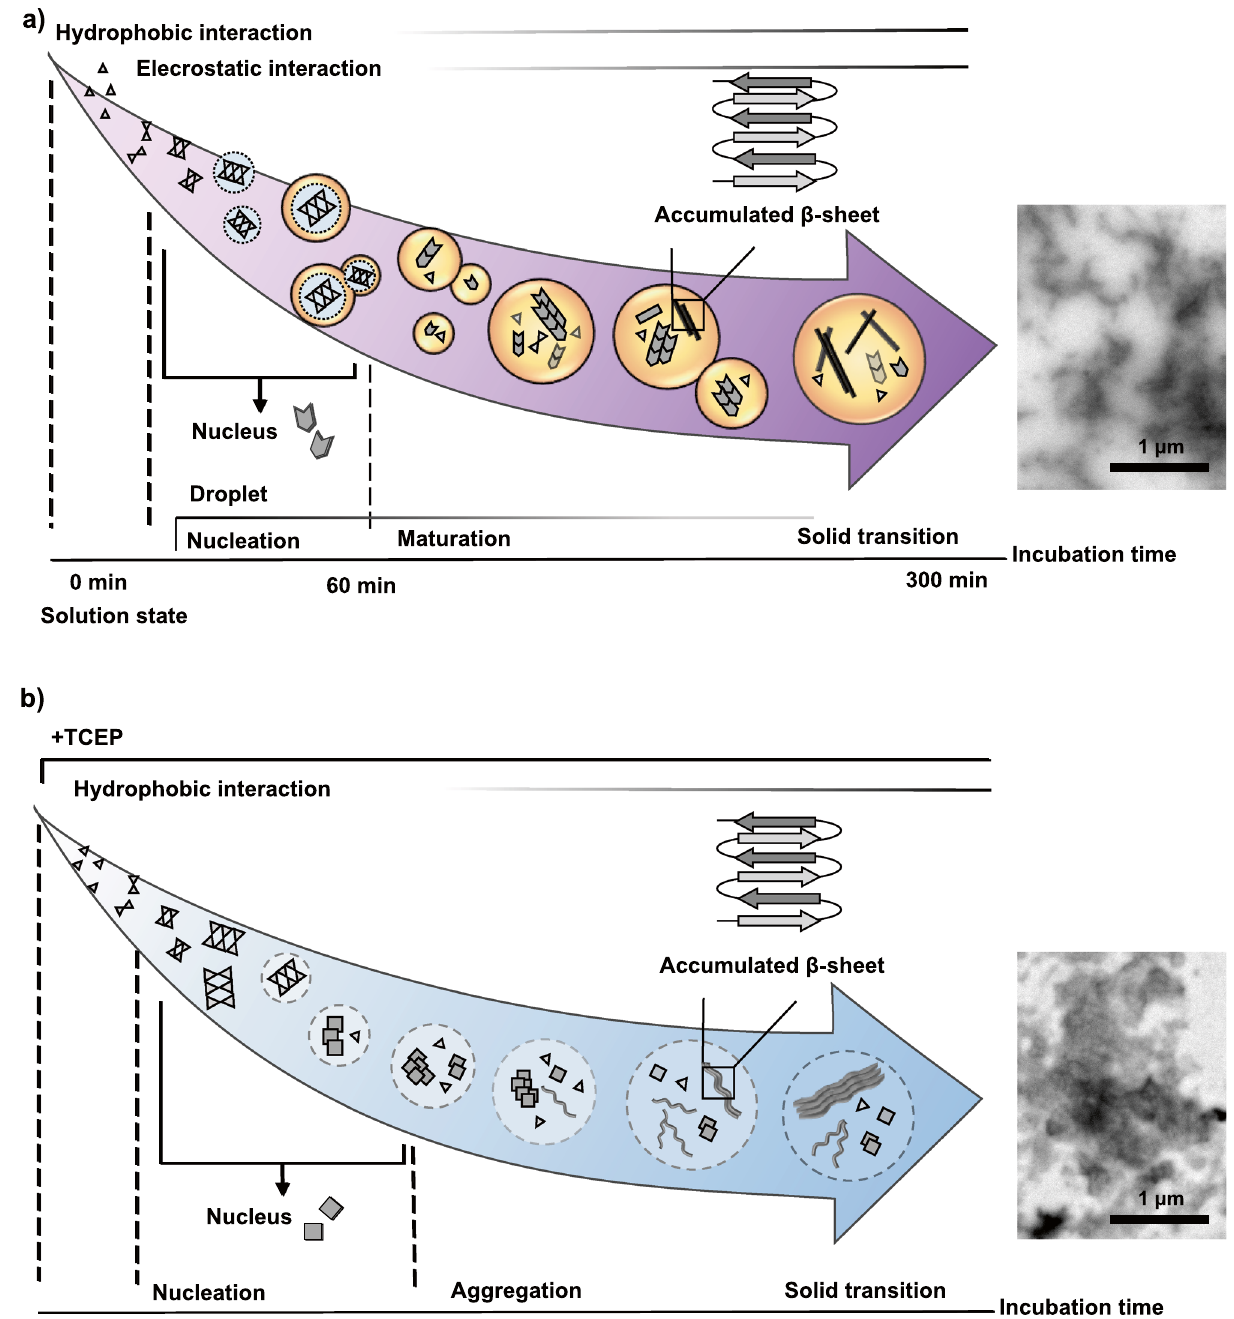
Figure 6. Scheme of the proposed mechanism for the formation of insulin (i)-amyloids ( a ) and (r)-amyloids ( b ). ( a ) The nucleuses of (i)-amyloid (hexagon) form insulin monomer (triangle). The droplets (orange circle) are formed in the elongation reaction (rectangle), and the maturation process proceeds in the droplets. ( b ) The nucleuses of (r)-amyloid (square) form insulin monomer (triangle). The maturation process of (r)-amyloid is dependent on incubation time (dotted